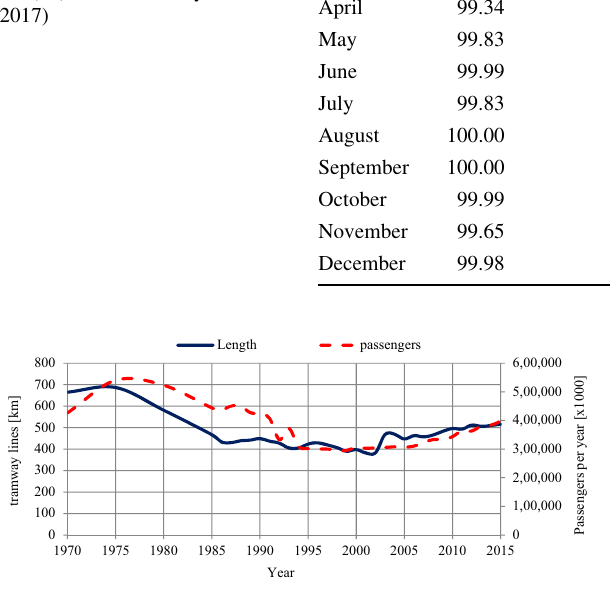
Table 5 Service delivery, vehicle punctuality and failure ratio and reliability improvement indicator values for the year 2016—Dubai Tramway (system APS Alstom ? vehicles Citadis